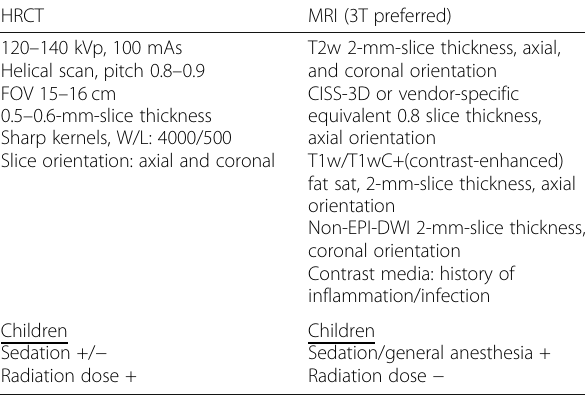
Table 1 HRCT and MRI protocols for pre-operative imaging and considerations in children